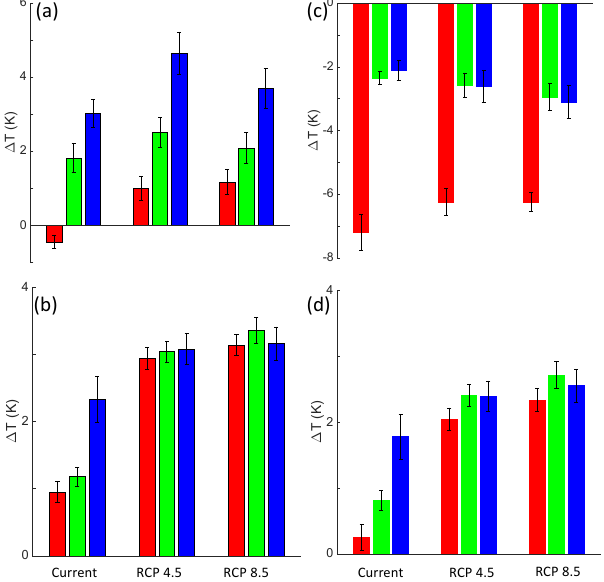
Figure 3. Urban heat island intensity from the control (CTR; a, b ) and white roof (WHT; c, d ) simulations. (a, c) daytime; (b, d) nighttime. Red, green, and blues bars denote dry, continental, and temperate climate zones, respectively. Error bars are ± 1 standard error.